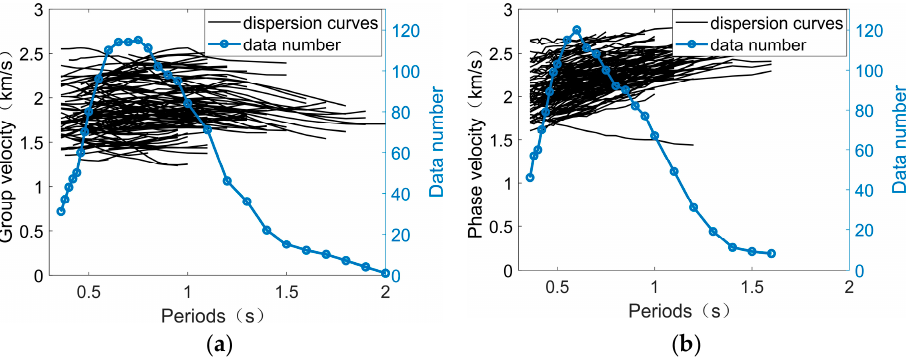
Figure 6. ( a ) The group-velocity and ( b ) phase-velocity dispersion curves in the period of 0.35–2 s. Black solid lines represent dispersion curves for each NCF. Blue bold lines and circles show the dispersion period and the corresponding dispersion